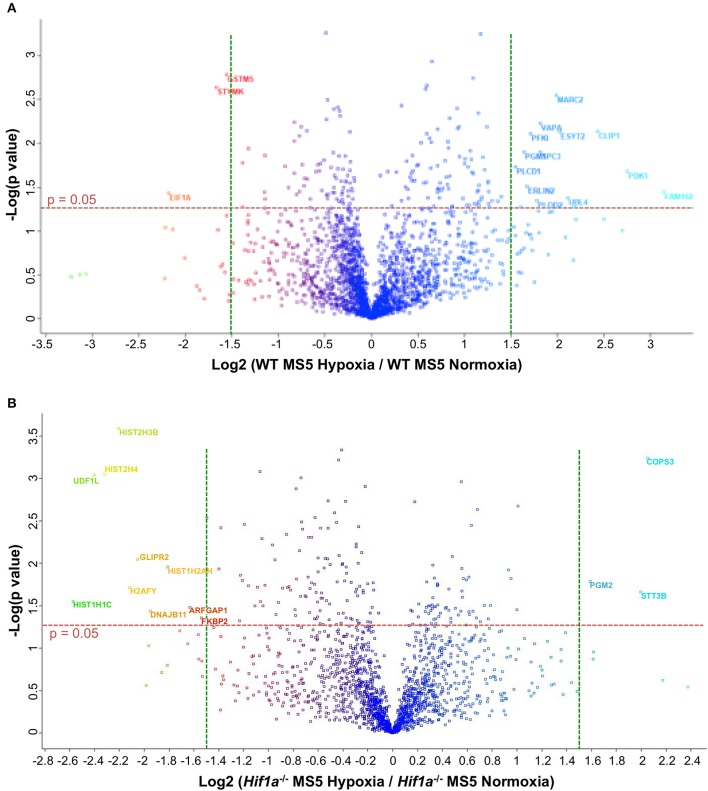
Volcano plots to compare effect of hypoxia on the proteome of WT and Hif1a−/− MS5 cells. Gene expression fold changes of normoxic vs. hypoxic (A) WT MS5 and (B)
Hif1a−/− MS5 cells are plotted in the x axis vs. Log10 of the p-values derived from a t-test (y axis). Red horizontal dashed lines represents a p-value of 0.05 [–Log (0.05) = ~1.3], while green vertical lines indicate Log2 fold changes of −1.5 (left) and 1.5 (right). Names of proteins with p < 0.05 and Log2 fold changes >1.5 are indicated.